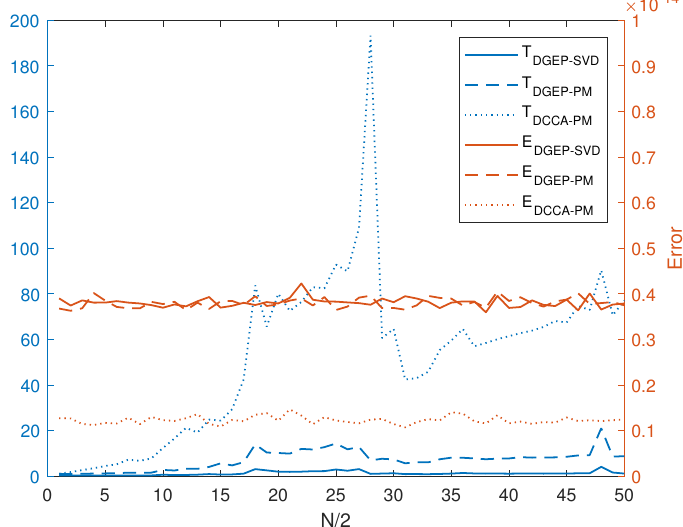
Figure 4. Performance of DCCA-PM and DGEP-PM in running time ( T / s ) and error ( E ) with respect to the number of local severs ( N ).